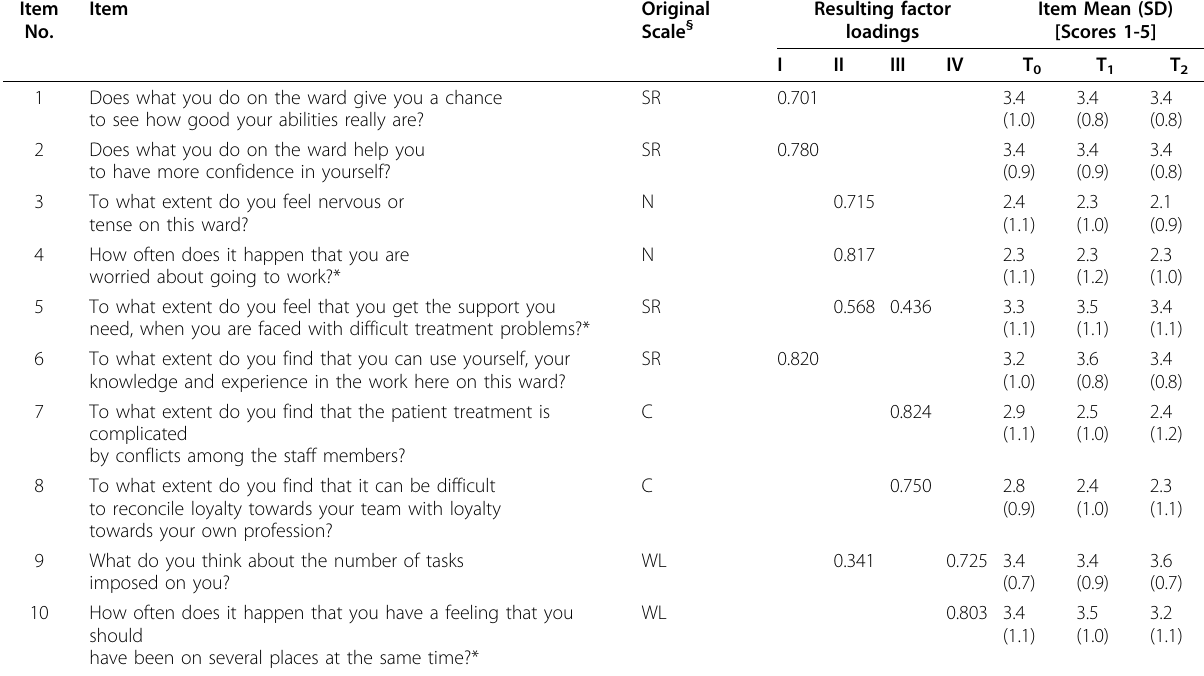
Table 1 Distribution of responses and item mean values of each item on the WES-10 and results of the factor analysis (items marked with * are recoded for the calculation of the subscales) Item